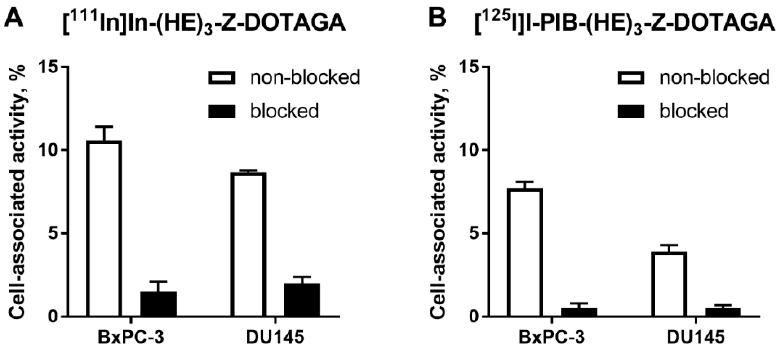
Figure 1. Binding specificity of ( A ) [ 111 In]In-(HE) 3 -Z HER3:08698 -DOTAGA and ( B ) [ 125 I]I-PIB-(HE) 3 - Z HER3:08698 -DOTAGA to human epidermal growth factor receptor type 3 (HER3)-expressing BxPC-3 and DU145 cancer cells in vitro. Concentration of radiolabeled compounds was 0.05 nM; for blocking, 1000-fold molar excess of non-labeled affibody molecule was added. Data are presented as mean from three samples ± standard deviation (SD).